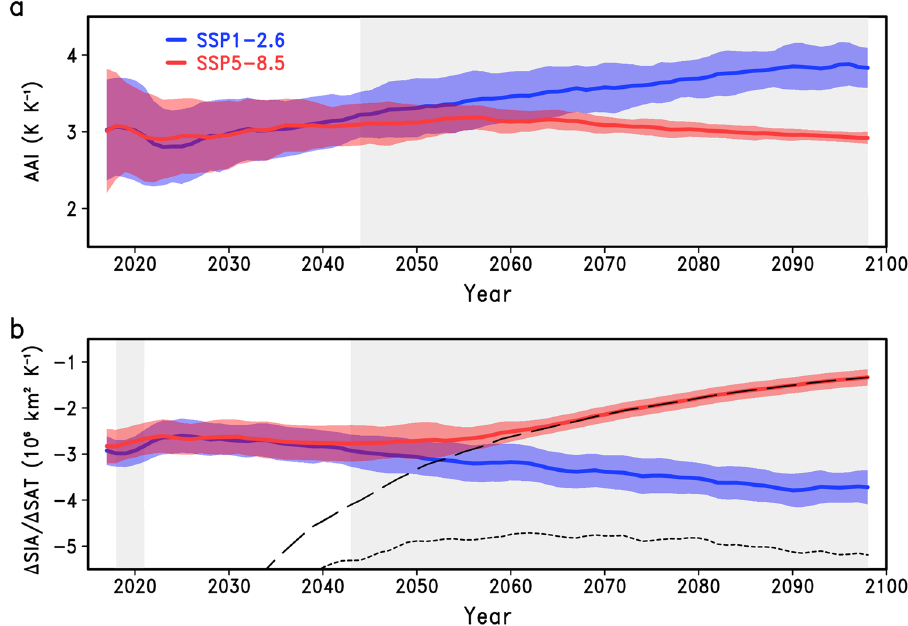
Fig. 2 Time evolution of changes in AAI and sea-ice area (SIA) under two emission scenarios in the MIROC6 large ensemble. a , b Time series of ( a ) AAI (K K − 1 ) and ( b ) September SIA change scaled by the global-mean SAT change (10 6 km 2 K − 1 ) from 2015 to 2100 (SSP1-2.6; blue, SSP5-8.5; red). All time series are smoothed with a 5-year running mean. The thick line denotes the ensemble mean, and the shading represents one standard deviation. Gray shading indicates that differences between SSP1-2.6 and SSP5-8.5 are signi fi cant at the 95% con fi dence level. In ( b ), long- and short-dashed lines indicate that SIA in September is zero, [de fi ned as the value of zero minus the 1980 – 2009 mean (scaled by the global-mean SAT change)], for SSP1-2.6 and SSP5- 8.5,